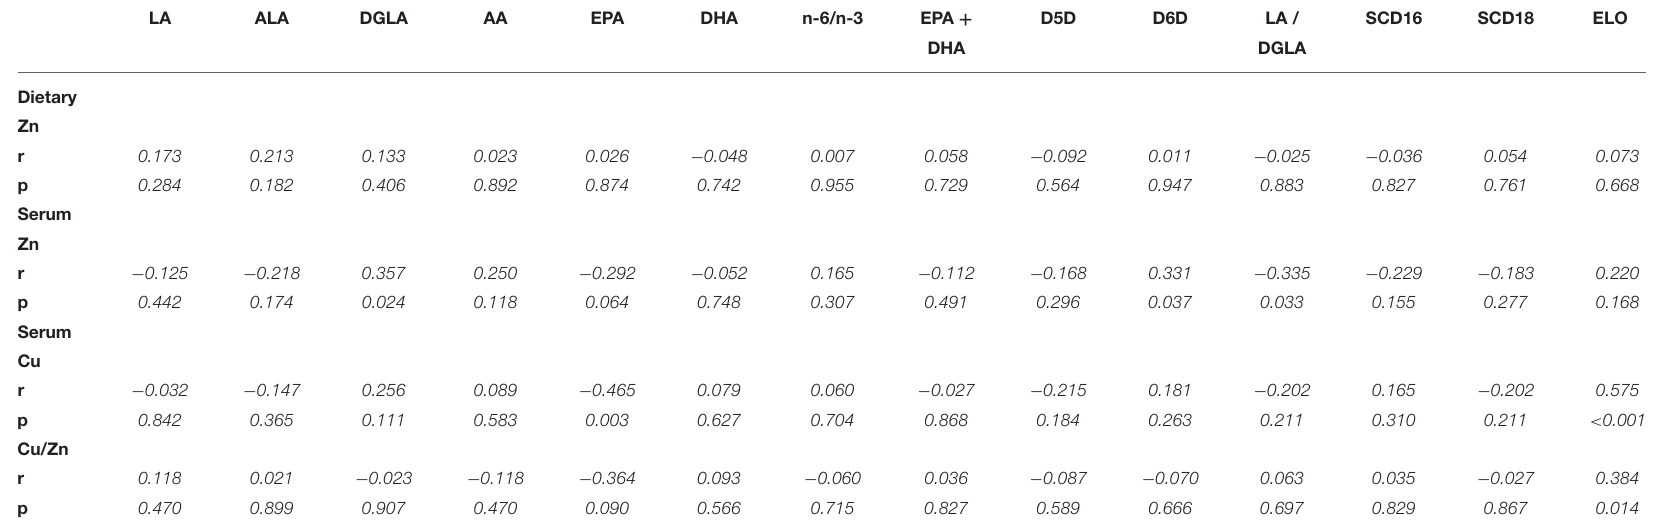
TABLE 5 | Correlation between Zinc intake and status values with plasma PUFA profile and estimated desaturase activity in hemodialysis